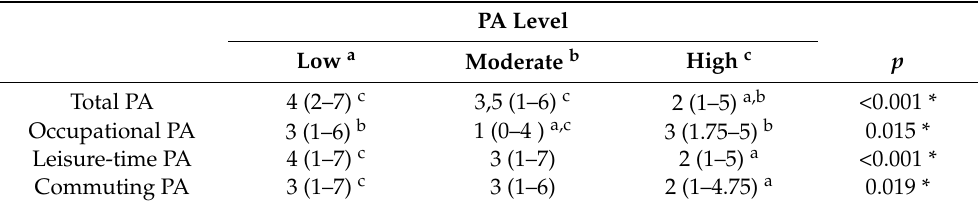
Table 3. Scores of mental illness (GHQ12) according to levels and domains of PA.